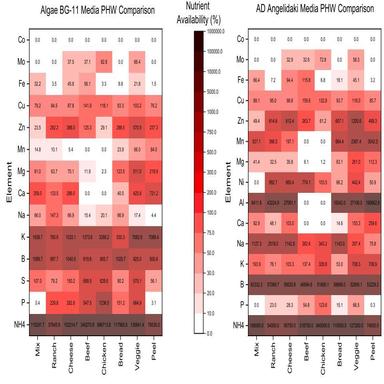
Heat map prospecting nutrient availability by comparing molarity based element concentrations of (a) algae and (b) anaerobic digestion nutrient mixtures to measured values in HTL-AP from optimized reaction conditions for each of the different food waste feedstocks.